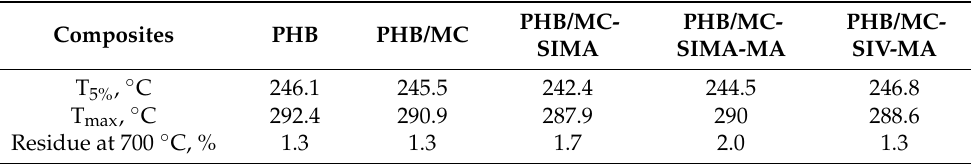
Figure 5. TGA ( a ) and DTG ( b ) curves of composites with differently modified celluloses. Table 2. TGA data for the PHB composites with differently modified celluloses .